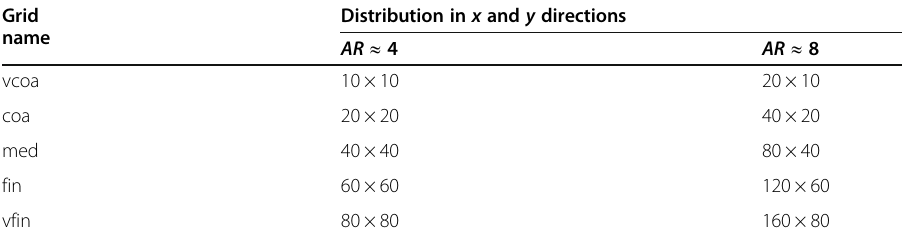
Table 5 Distribution of background quadrilateral grids in radical and circumferential